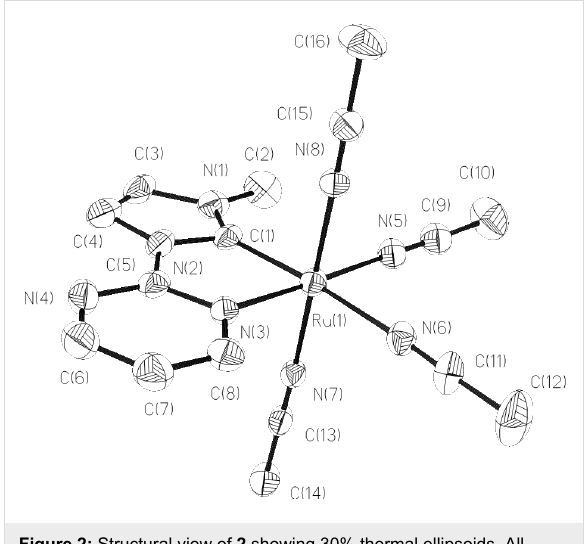
Figure 2: Structural view of 2 showing 30% thermal ellipsoids. All hydrogen atoms and PF 6 − were omitted for clarity. Selected bond lengths (Å) and angles (deg): Ru(1)–C(2) 1.989(7), Ru(1)–N(5) 2.023(5), Ru(1)–N(8) 2.027(5), Ru(1)–N(7) 2.033(6), Ru(1)–N(4) 2.064(5), Ru(1)–N(6) 2.113(6), C(2)–Ru(1)–N(5) 88.3(2), C(2)–Ru(1)–N(8) 91.2(2), N(5)–Ru(1)–N(8) 179.3(2), C(2)–Ru(1)–N(7)